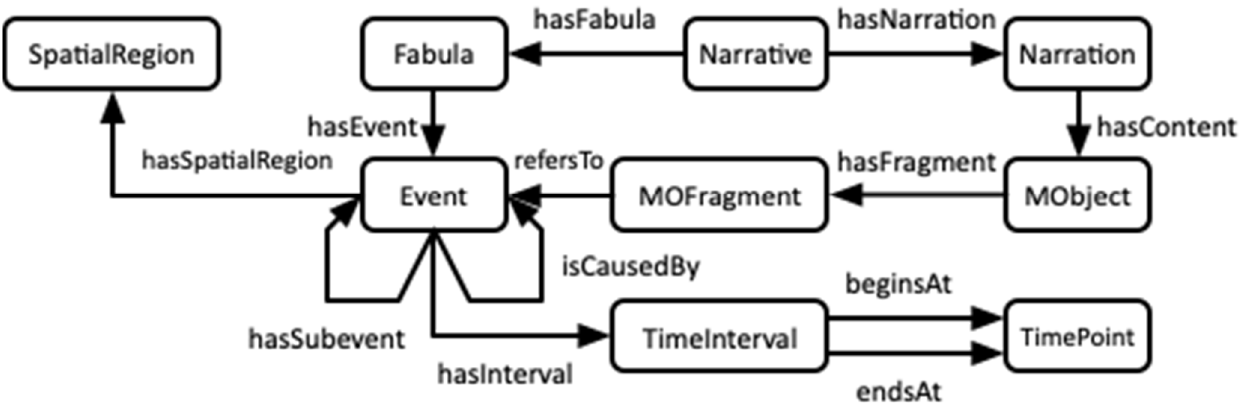
Figure 13. Main classes and properties of the Narrative Ontology.